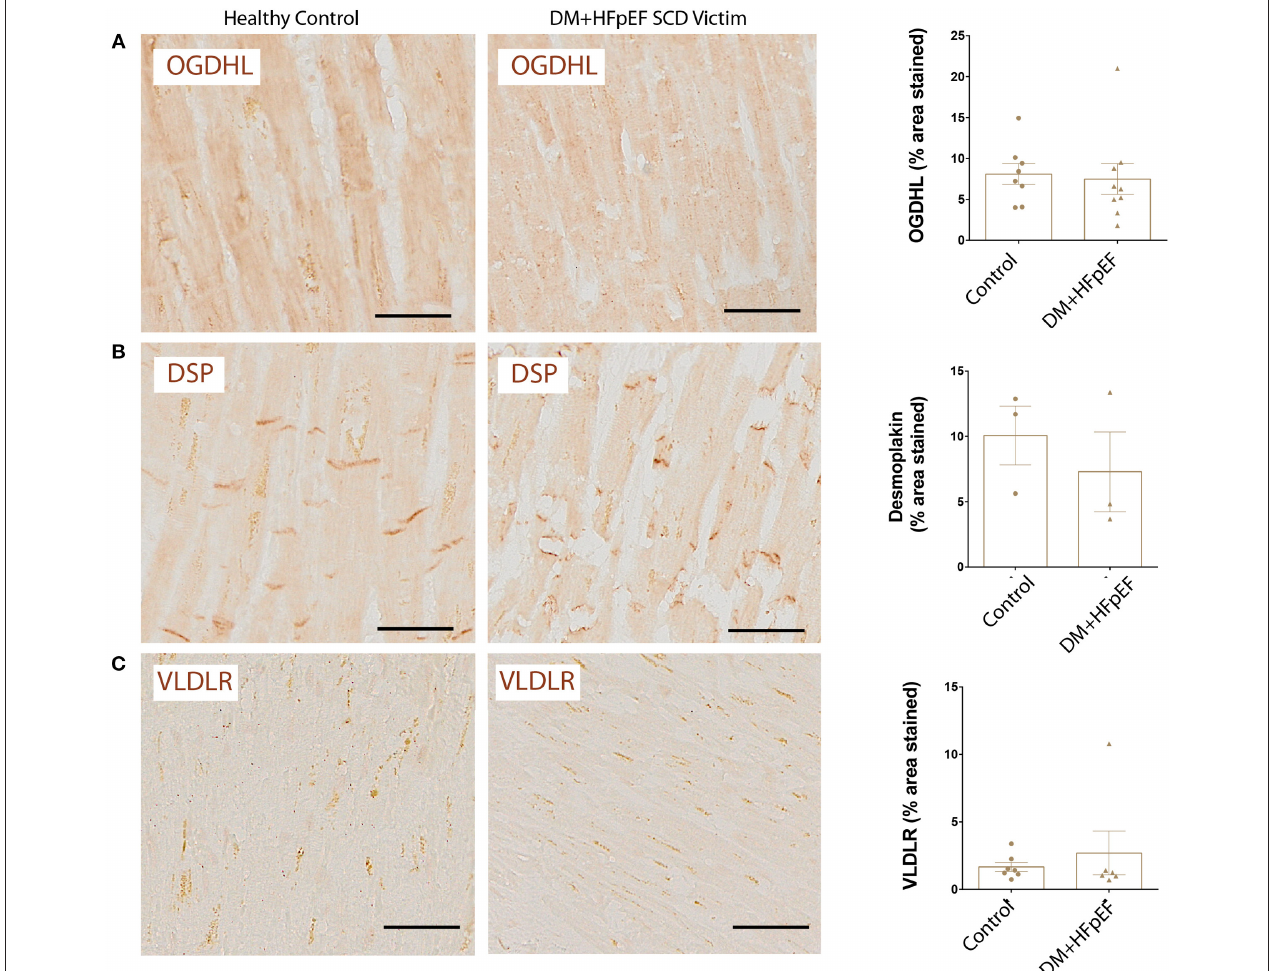
FIGURE 4 | Unchanged expression of OGDHL, DSP, and VLDLR proteins in SCD victims with DM + HFpEF. Immunostaining of cardiac biopsies of SCD victims with both HFpEF and DM shows no significant changes in the expression pattern of OGDHL (A) , DSP (B) and VLDLR (C) compared to control hearts. Data are mean ±